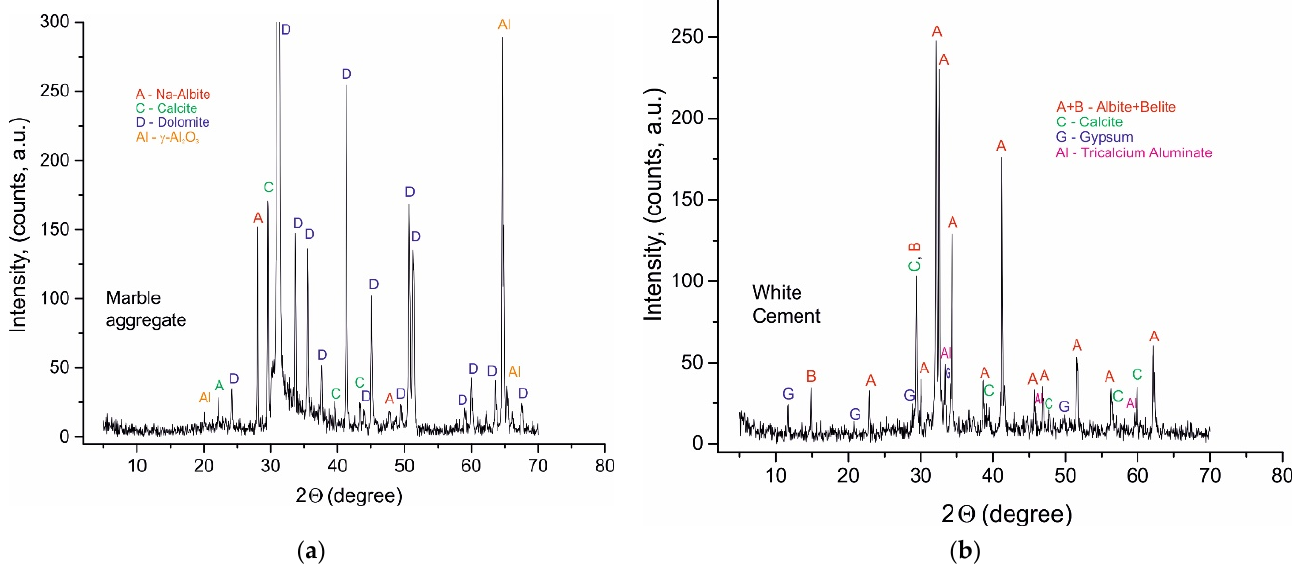
Figure 1. ( a ) PXRD pattern of marble powder aggregate. ( b ) PXRD pattern of white Portland cement.